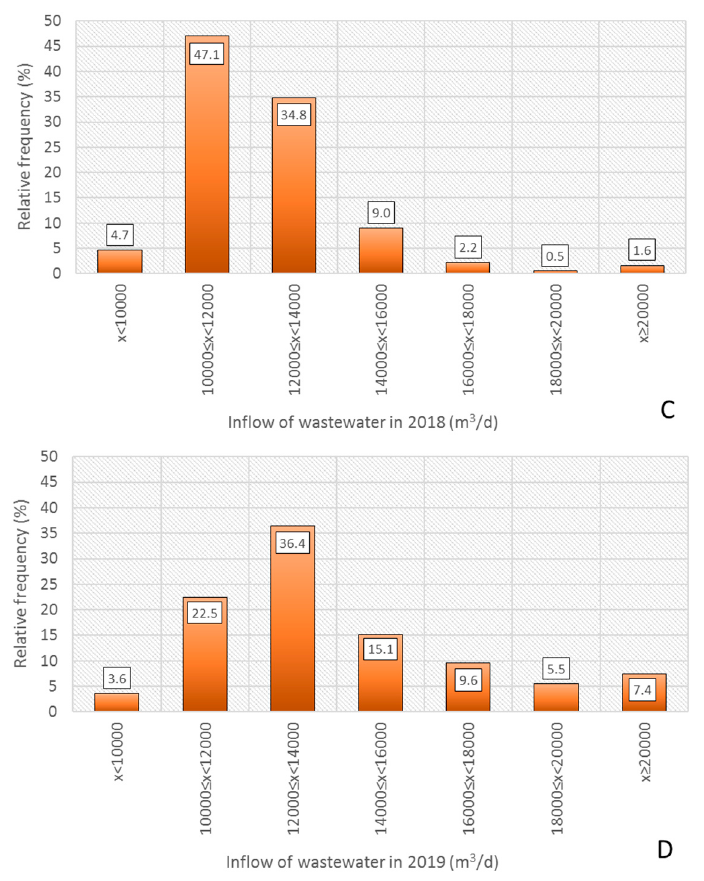
Figure 3. The histogram of the frequency of dependence of characteristic daily wastewater inflows in individual surveyed years. ( A )-2016 year, ( B )-2017 year, ( C )-2018 year, ( D )-2019 year.